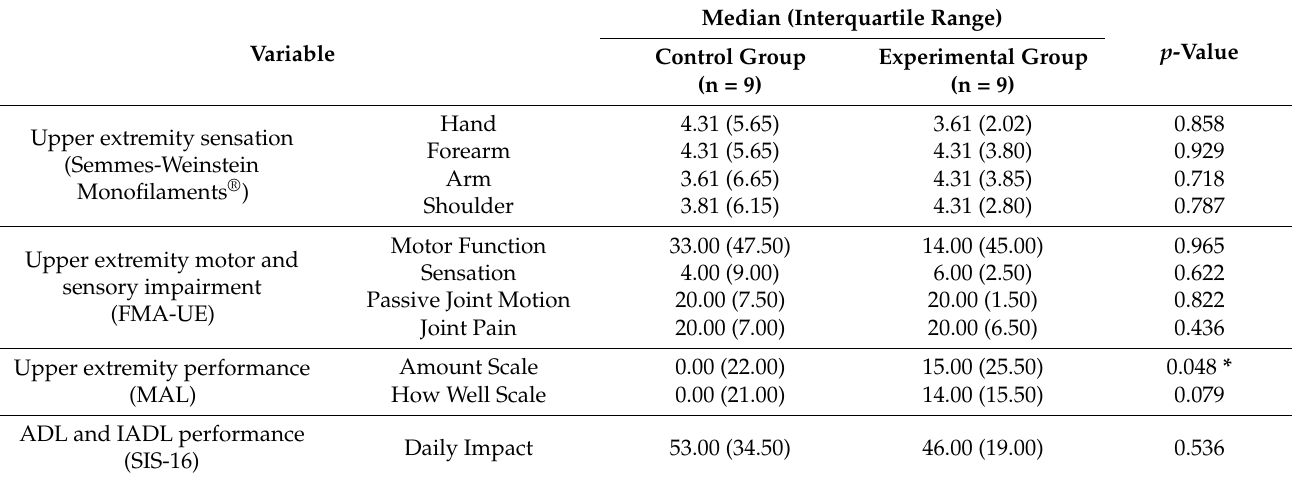
Table 2. Baseline function and performance variables of control and experimental groups (n = 18).